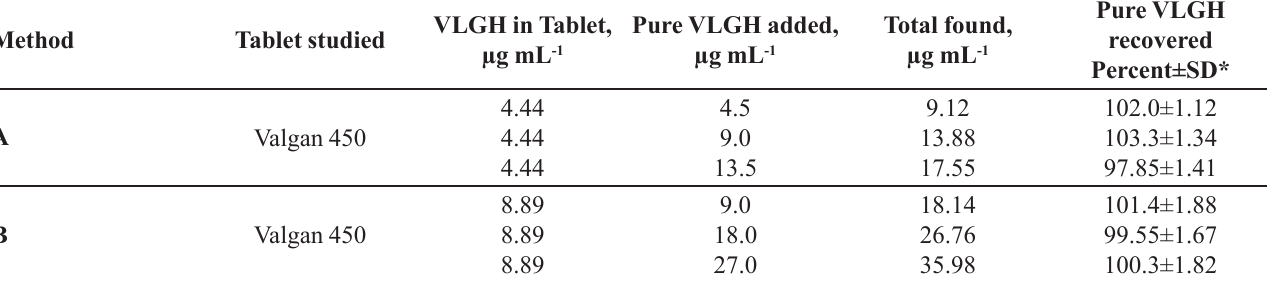
TABLE V - Results of recovery experiment through standard-addition method